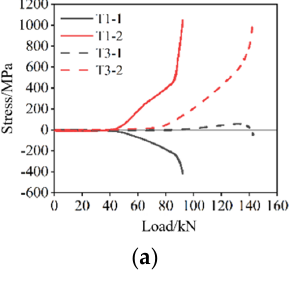
Figure 7. Stress − load curve: ( a ) thickness group; ( b ) bolt spacing group; ( c ) sti ff ener rib